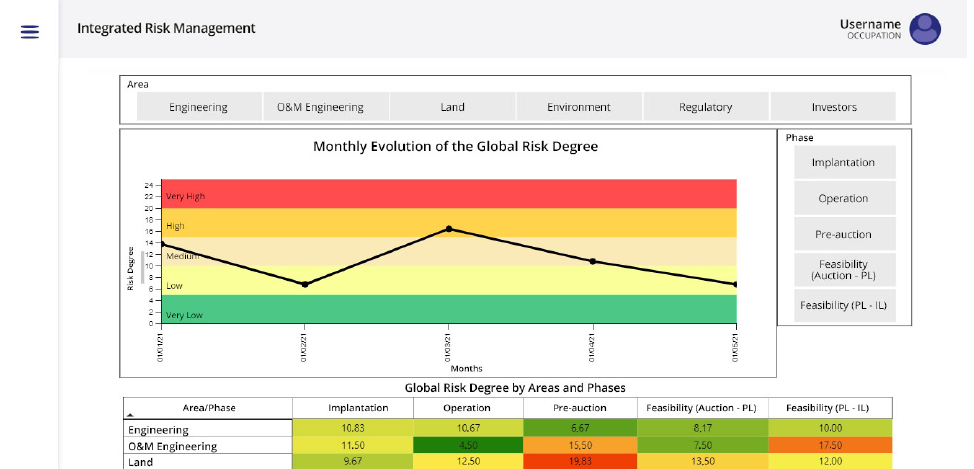
Figure 9. Web-based dashboard system displaying the risk trend.